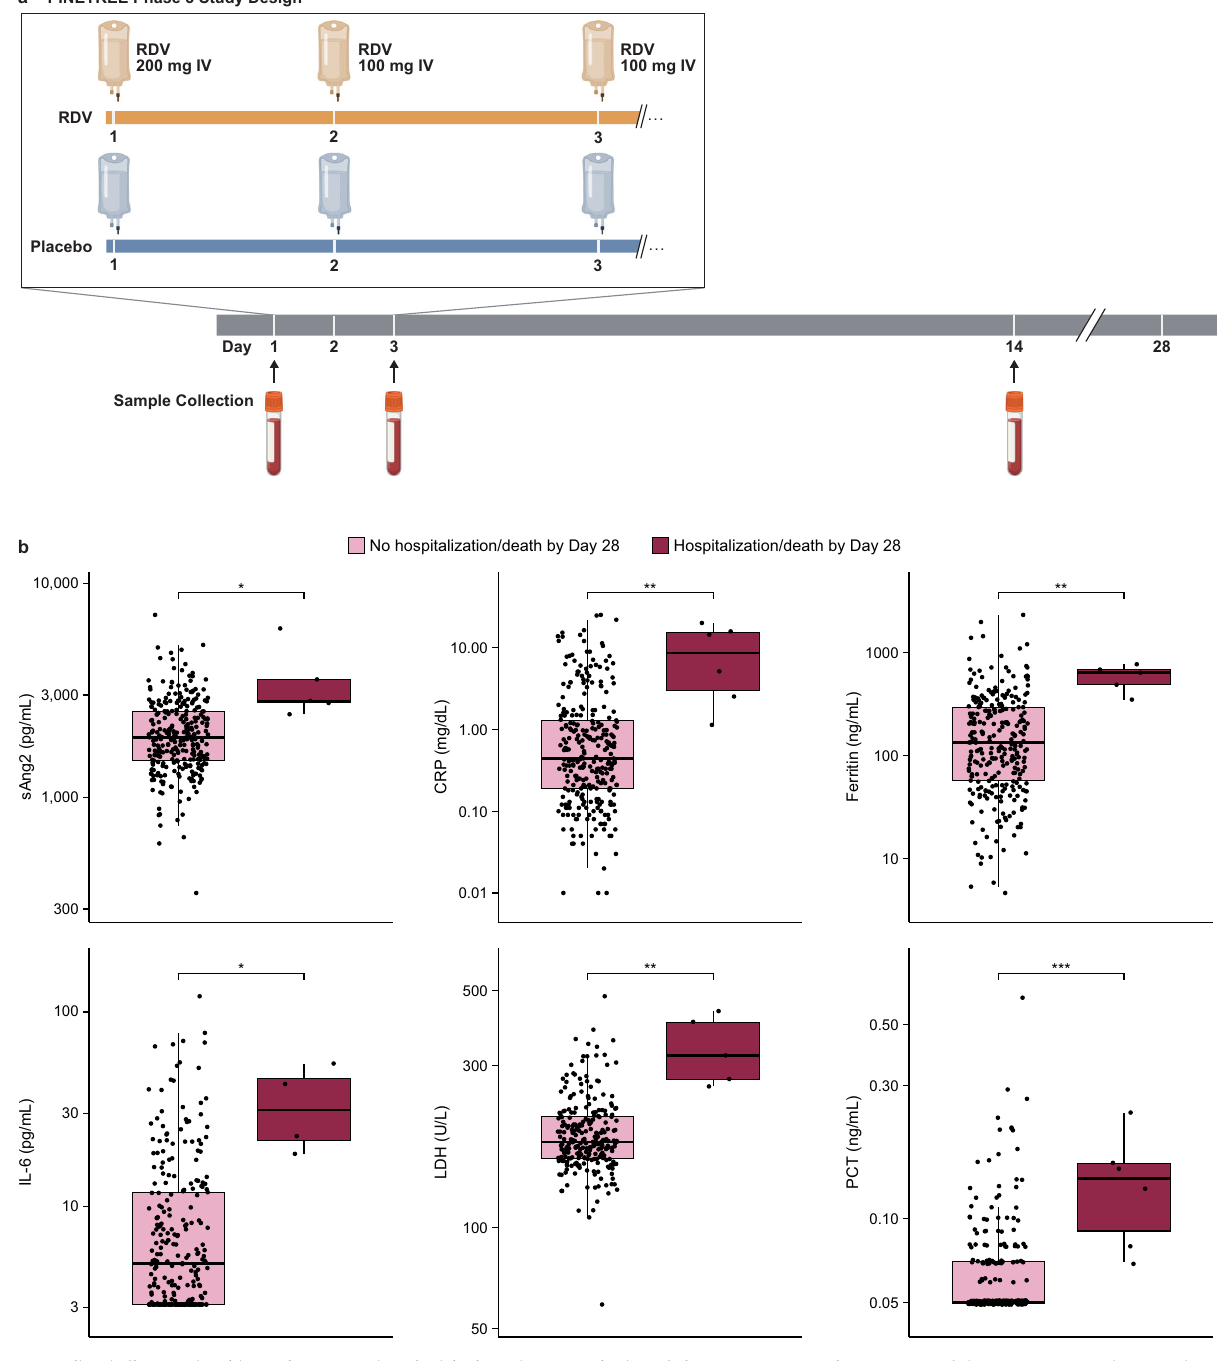
Fig. 1 Baseline in fl ammation biomarkers associated with the primary endpoint of the PINETREE study. a Design of the PINETREE study, a randomized, double-blind, placebo-controlled Phase 3 clinical trial in patients at high-risk of severe COVID-19. Participants were randomly assigned (1:1) to receive remdesivir (RDV) or placebo every day for 3 doses. Serum and plasma were collected for biomarker evaluation in a subset of participants at day 1, day 3, and day 14. b Box plots of signi fi cantly different (FDR < 0.05) biomarkers at baseline (day 1) in patients who met the primary endpoint of hospitalization or death by day 28 (purple, soluble Angiopoietin 2 (sAng2): n = 288; ferritin: n = 275; interleukin-6 (IL-6): n = 267; lactate dehydrogenase (LDH): n = 246; C-reactive protein (CRP): n = 289; procalcitonin (PCT): n = 288) vs. those who did not (pink; IL-6: n = 4; sAng2, ferritin, LDH: n = 5; CRP, PCT: n = 6). *FDR < 0.05; **FDR < 0.01; ***FDR < 0.001, ****FDR < 0.0001. The line within each box denotes the median and each box extends to the 25 th and 75 th percentiles. The whiskers indicate 1.5 interquartile range. Signi fi cance was determined using a Wilcoxon Rank Sum Test.